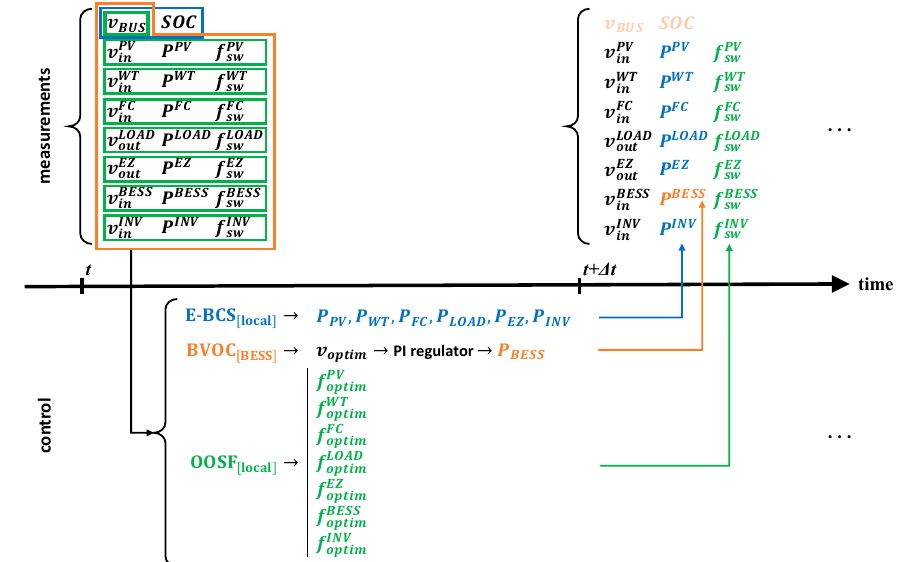
Figure 4. MG management flow chart describing the process of simultaneous E-BCS (in blue), BVOC BESS (in orange) and OOSF (in green). Each time step, say in time 𝑡 , the E-BCS local controller of each converter 𝑖 receives the measured value of 𝑣 (cid:3029)(cid:3048)(cid:3046) and SOC and, from them, determines the correspondent 𝑃 (cid:3036) . The BVOC BESS centralized controller (i.e., the BESS controller) receives all the MG’s measured values and, from them, calculates 𝑣 (cid:3042)(cid:3043)(cid:3047)(cid:3036)(cid:3040) ; a PI regulator determines then 𝑃 (cid:3003)(cid:3006)(cid:3020)(cid:3020) from this reference. The OOSF local controller of each converter 𝑖 receives the measured value of 𝑣 (cid:3036)(cid:3041)(cid:3036) , 𝑣 (cid:3042)(cid:3048)(cid:3047)(cid:3036) (note that one of these two is invariably equal to 𝑣 (cid:3029)(cid:3048)(cid:3046) for all converters 𝑖 ), 𝑃 (cid:3036) , and 𝑓 (cid:3046)(cid:3050)(cid:3036) and, from them, calculates the optimal 𝑓 (cid:3046)(cid:3050) (cid:3042)(cid:3043)(cid:3047)(cid:3036)(cid:3040)(cid:3036) . The calculated values 𝑃 (cid:3036) and 𝑓 (cid:3046)(cid:3050) (cid:3042)(cid:3043)(cid:3047)(cid:3036)(cid:3040)(cid:3036) by the three algorithms are then imposed and, thus, they will coincide with the measured values in the next time step 𝑡 + Δ𝑡 . Measured 𝑣 (cid:3029)(cid:3048)(cid:3046) and SOC appear in light orange in 𝑡 + Δ𝑡 because, although they are not directly determined by BVOC BESS , they are highly influenced by 𝑃 (cid:3003)(cid:3006)(cid:3020)(cid:3020) .